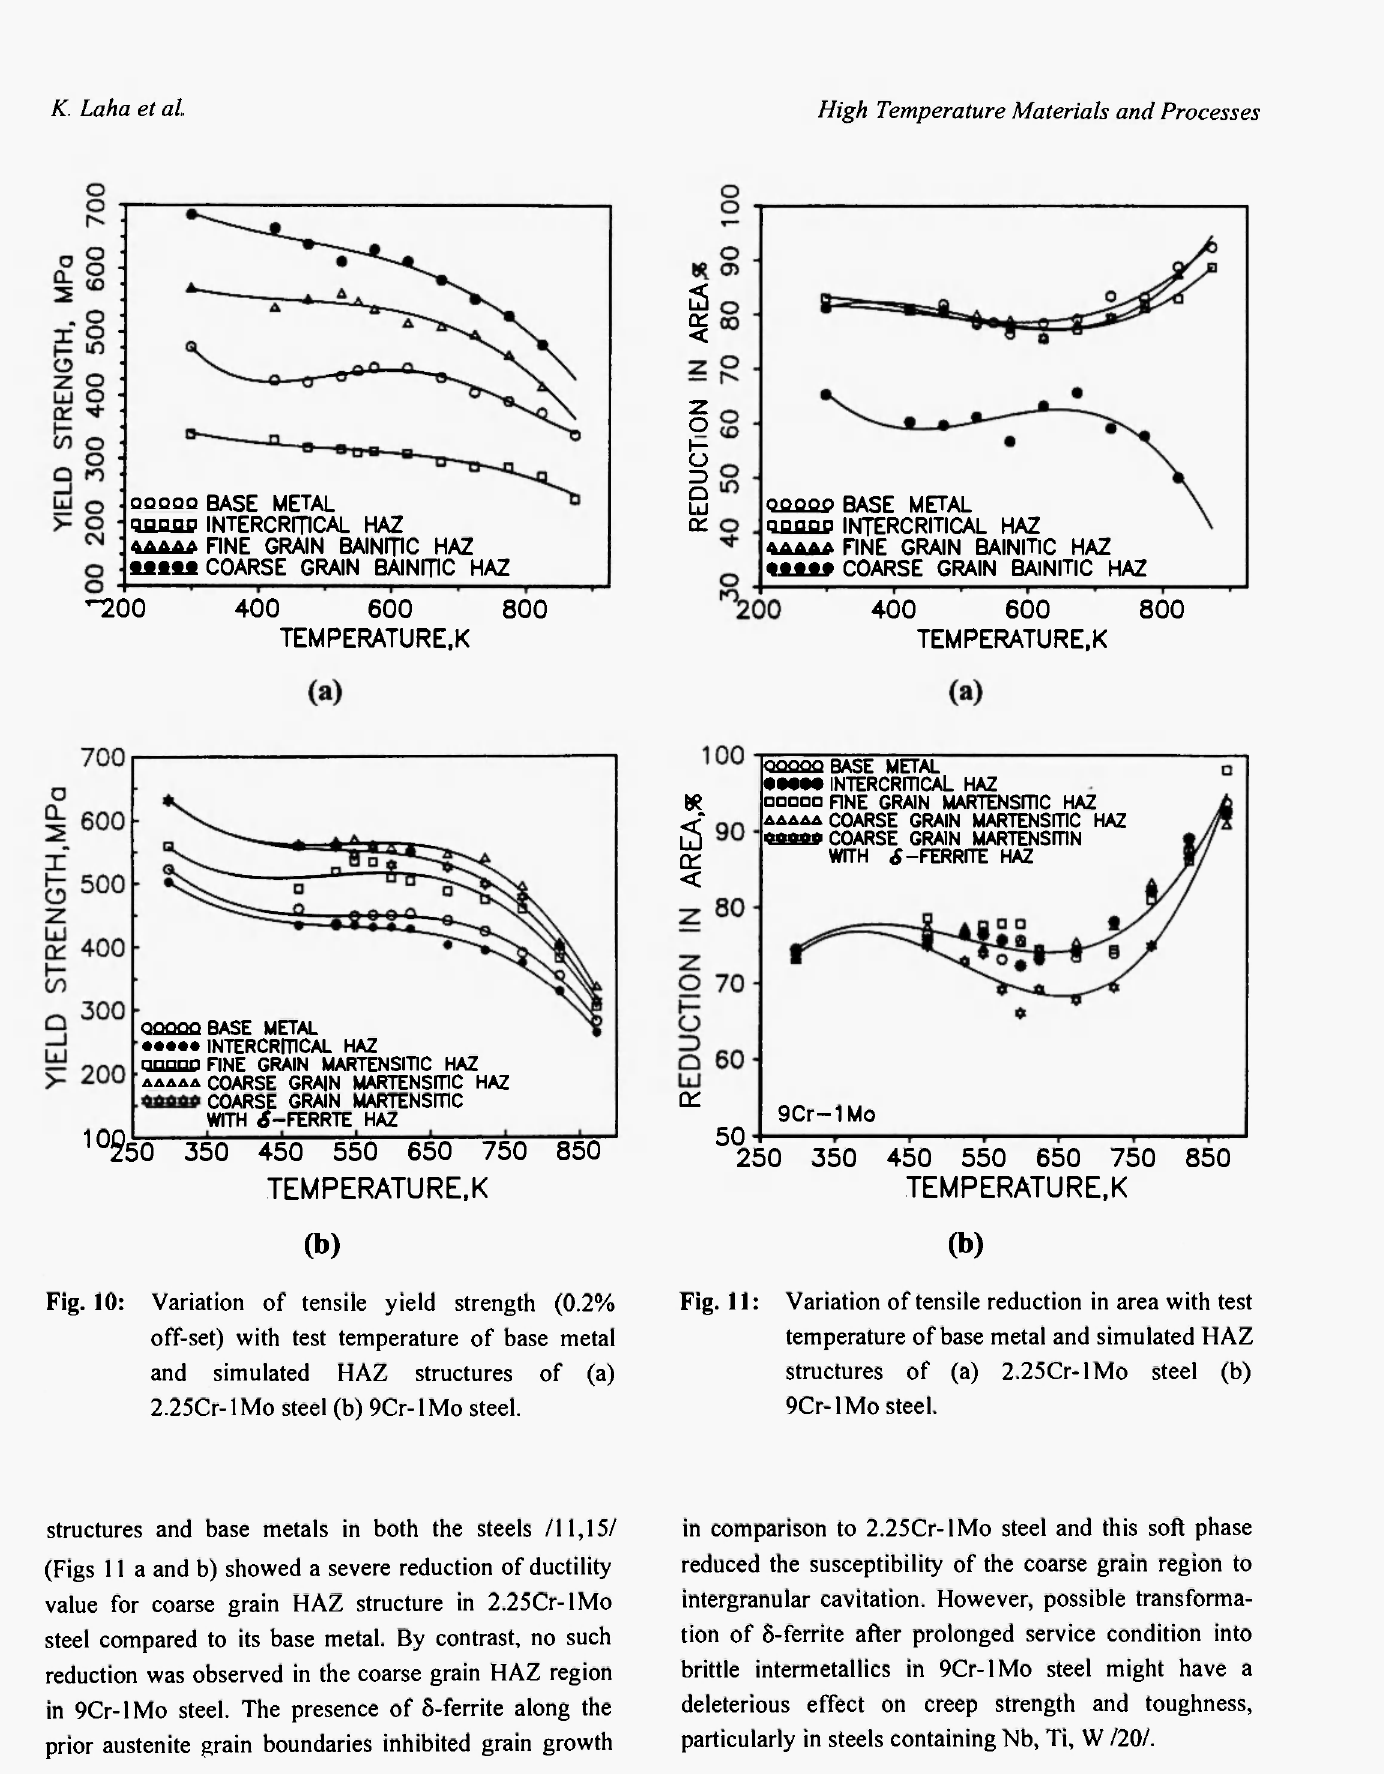
Fig. 11: Variation of tensile reduction in area with test temperature of base metal and simulated HAZ structures of 2.25Cr-lMo (b) 9Cr-lMo